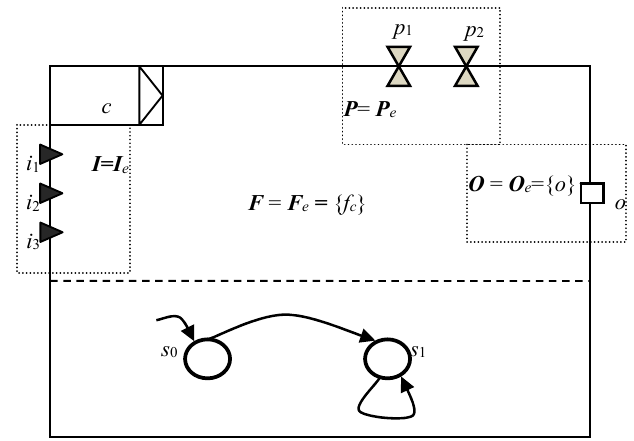
Figure 5. The diagram definition of the connector.